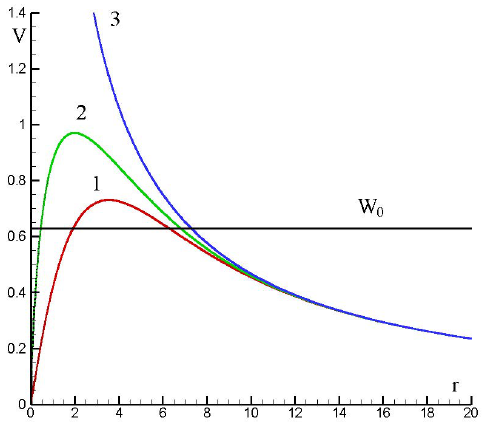
of the middle layer is indicated by the blue dashed curve.